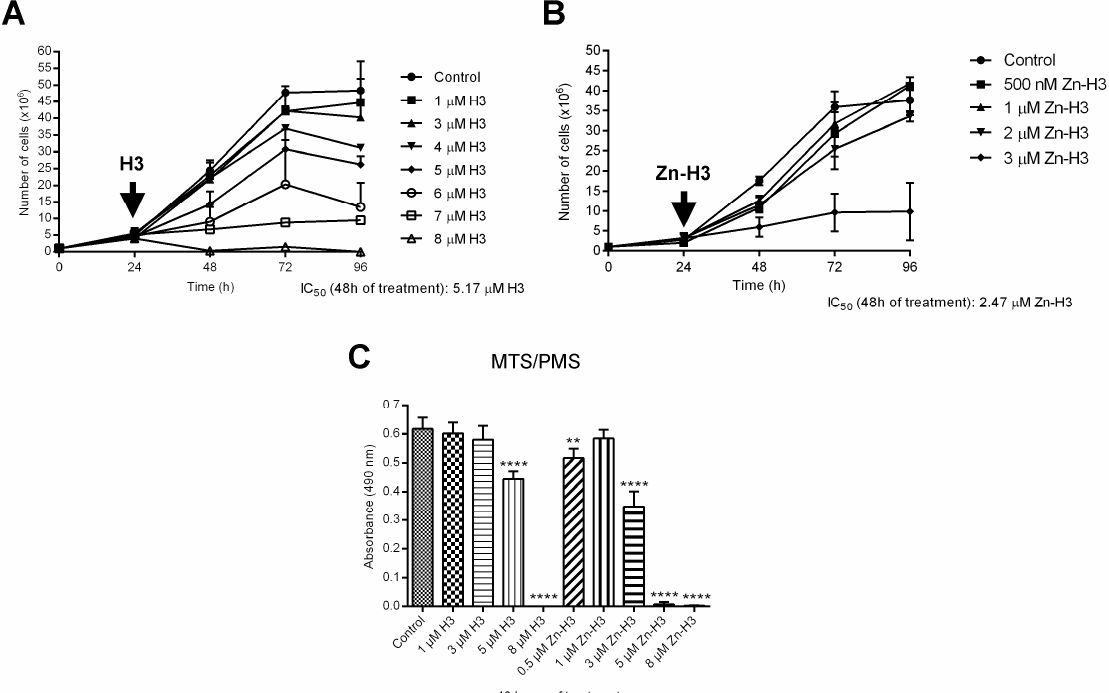
Figure 3. Growth curves of Leishmania amazonensis promastigotes treated with different concentrations of H3 ( A ) and Zn- H3 ( B ) during 96 h. Compounds were added with 24 h of growth (arrow). ( C ) Cell viability assay in promastigotes after 48 h of treatment. At least three experiments were carried out; each bar represents the standard deviation. One-way ANOVA with Dunnett’s post hoc test was used for statistical analysis. Asterisks mean different degrees of significance between treated groups and the control. p values: ** p < 0.01; **** p < 0.0001.